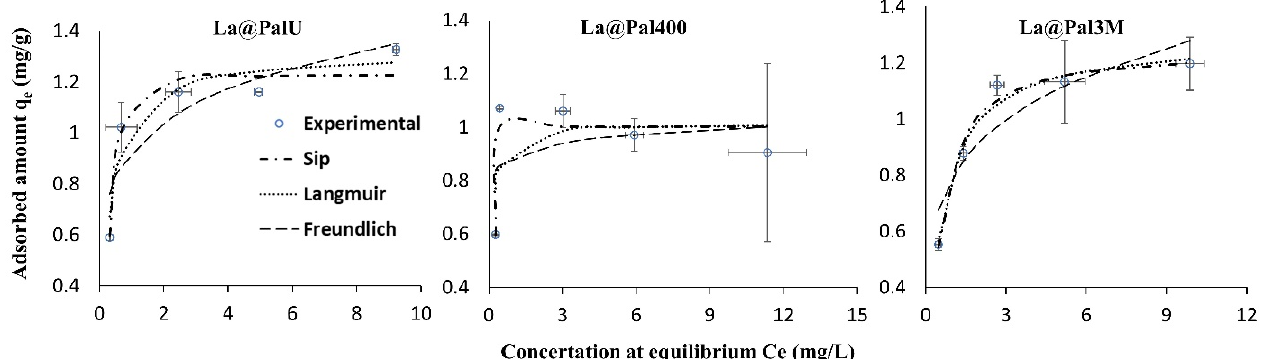
Figure 5. The adsorption of phosphate on modified palygorskite and various models to predict the adsorption capacity of the material in the given conditions.